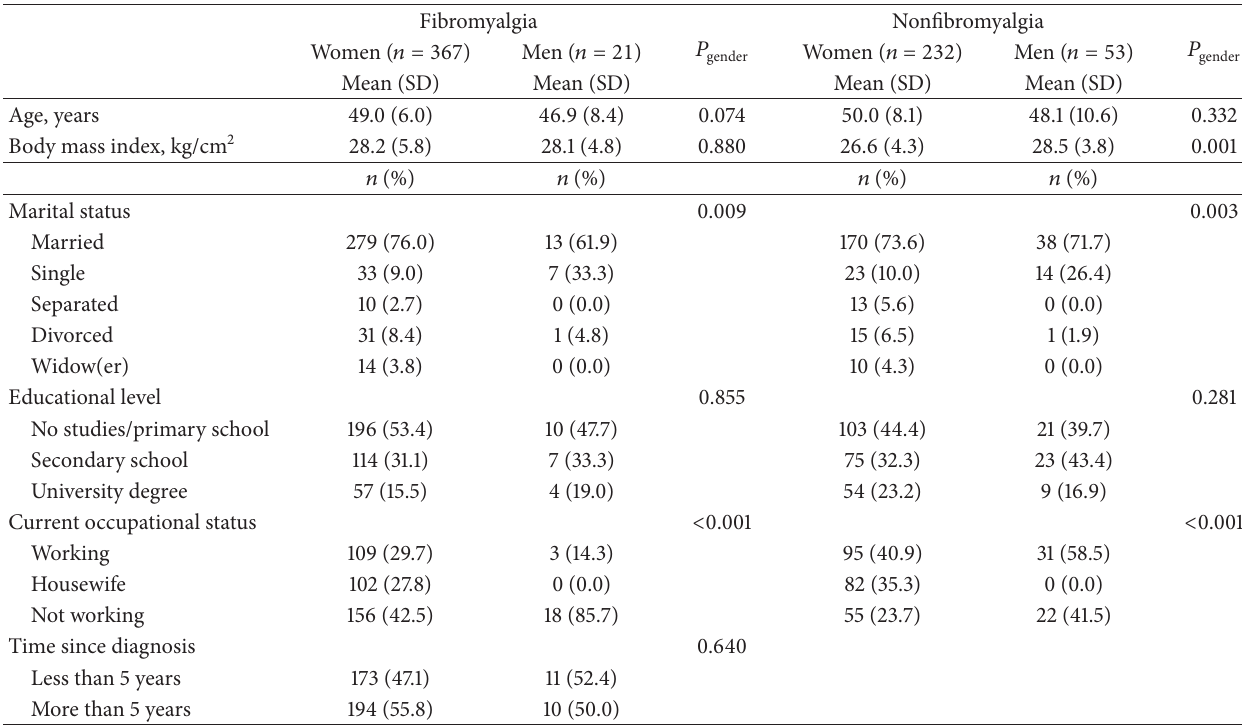
Table 1: Clinical and sociodemographic variables in women and men, separated by the presence or absence of